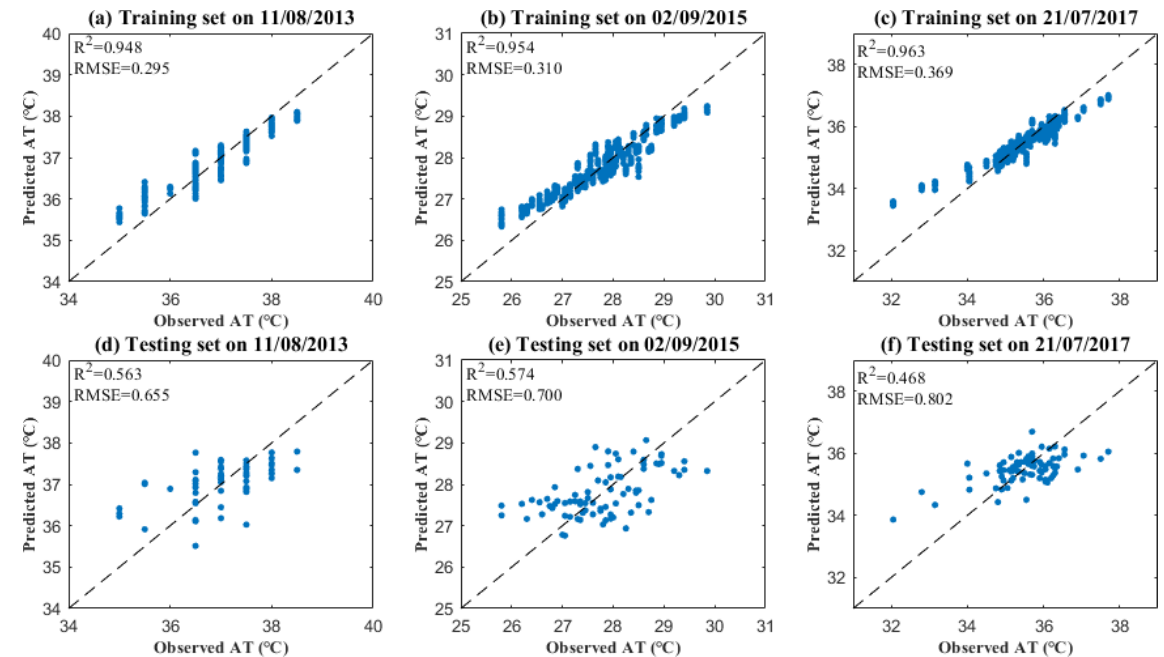
Figure 5. Scatterplot of predicted and observed air temperature: 5-fold cross validation (CV) for the training set on (a) 11 August 2013, (b) 2 September 2015, and (c) 21 July 2017; 5-fold CV for the testing set on (d) 11 August 2013, (e) 2 September 2015, and (f) 21 July 2017.